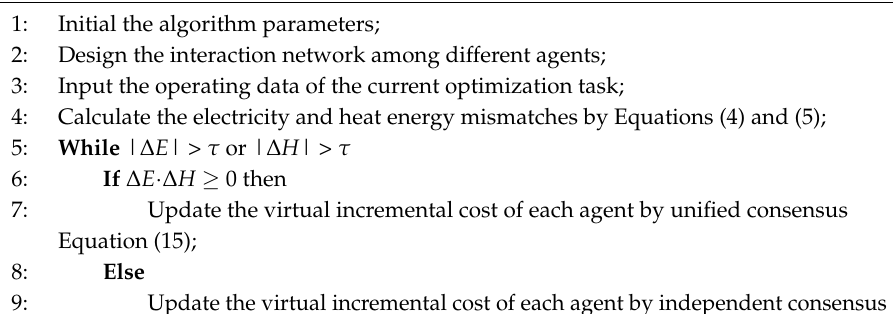
Algorithm 1. ACA for distributed